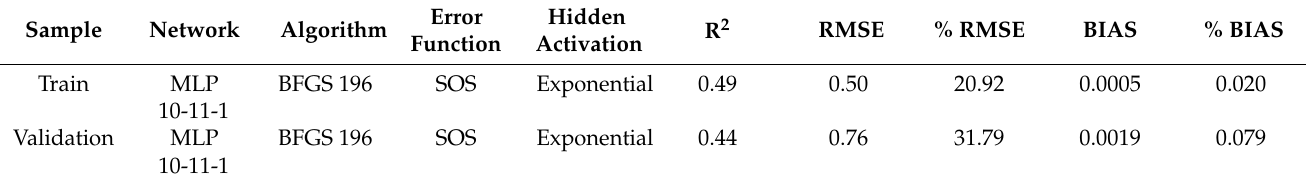
Table 10. Characteristics of RBF and MLP-based ANNs and associated metrics for diameter model training and